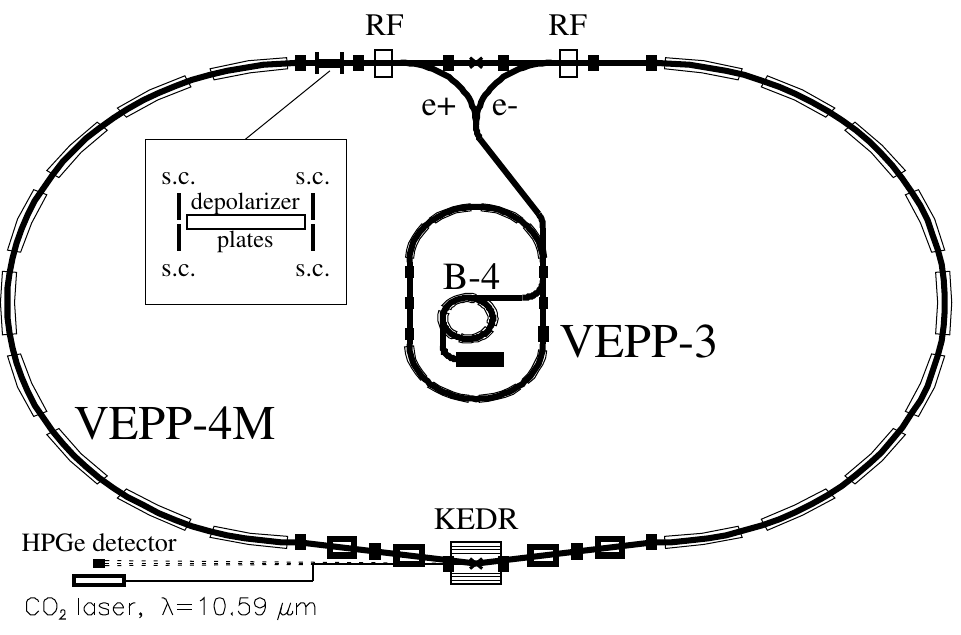
Figure 1 . The VEPP-4M e + e (cid:0) collider with KEDR